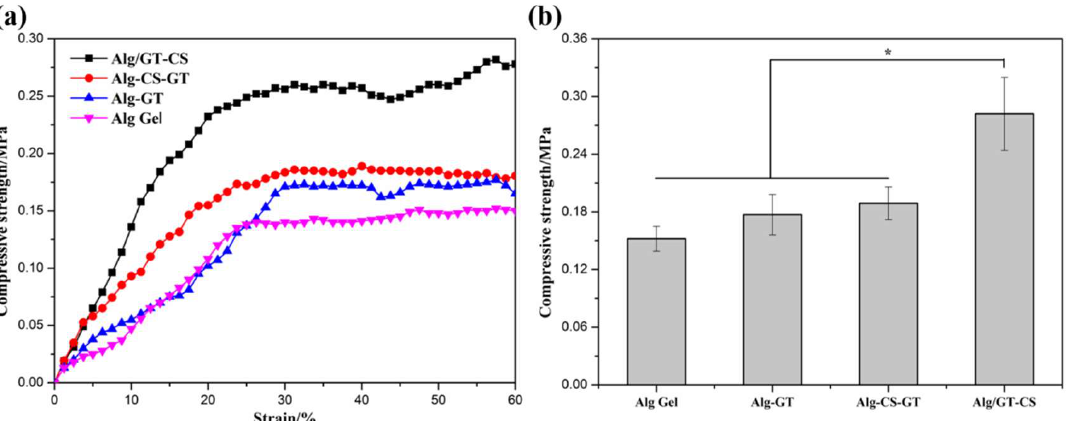
Figure 4. ( a ) Stress–strain curves and ( b ) compressive strength of ALG Gel, Alg-GT, Alg-CS-GT and ALG/GT-CS. * represents p < 0.05, indicating significant